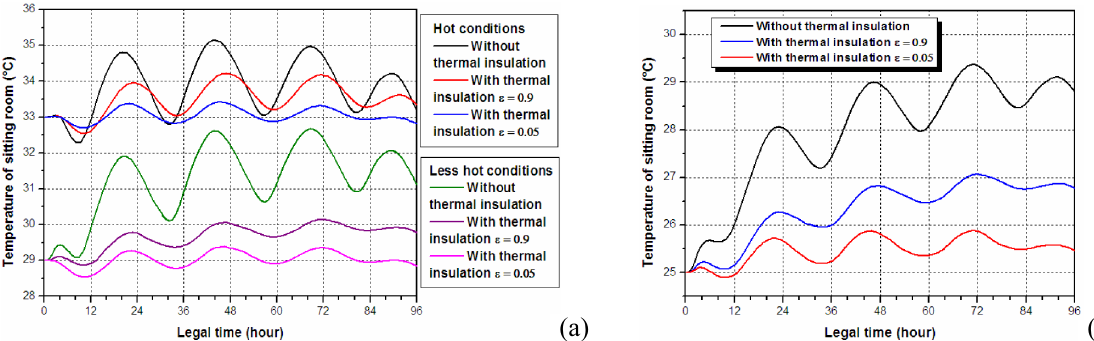
Fig. 4. Predicted air temperature of the sitting room, after (a) and before (b) the thermal storage.